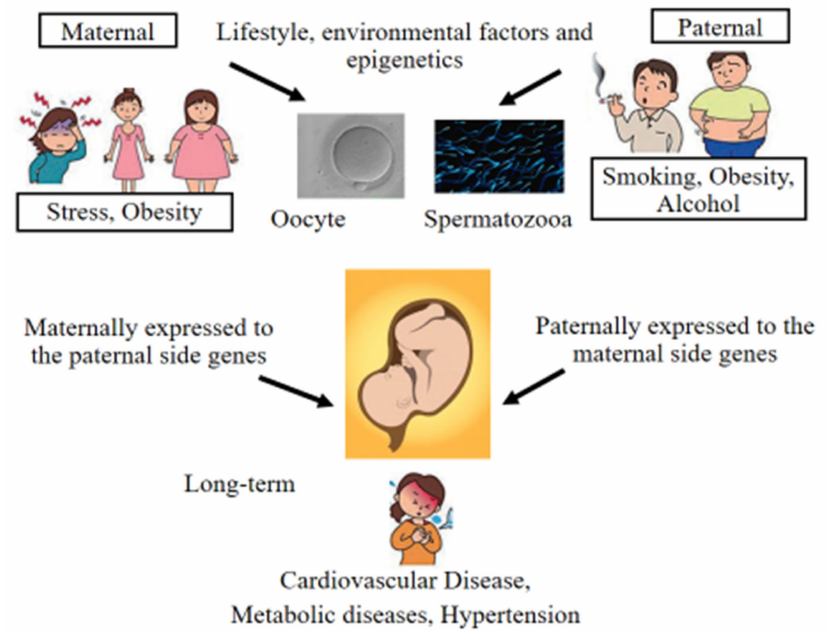
Figure 4. Paternal and maternal lifestyle prior to conception may affect sperm and oocyte epi- genetic changes, offspring epigenetics, and phenotypic abnormalities, including increased risk of cardiovascular and metabolic disease in later